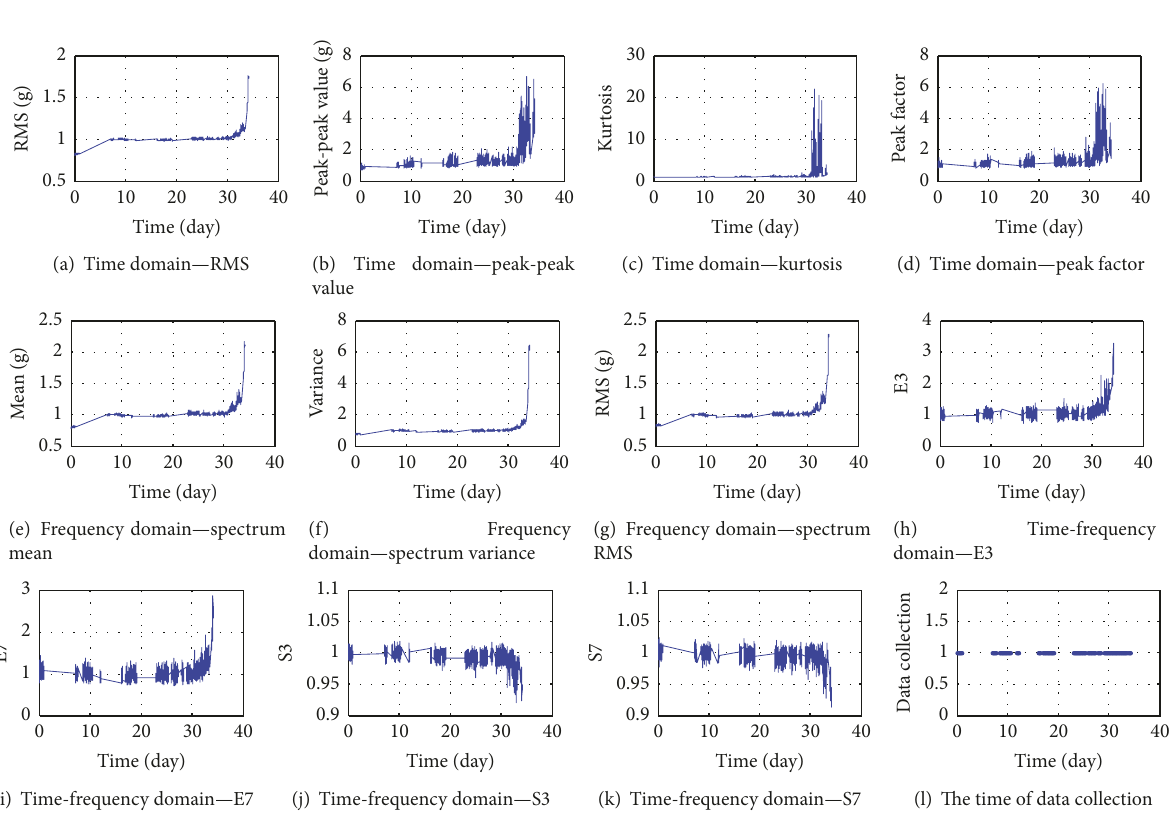
Figure 5: High test lifetime relative feature data (overall degradation process). Table 2: Point